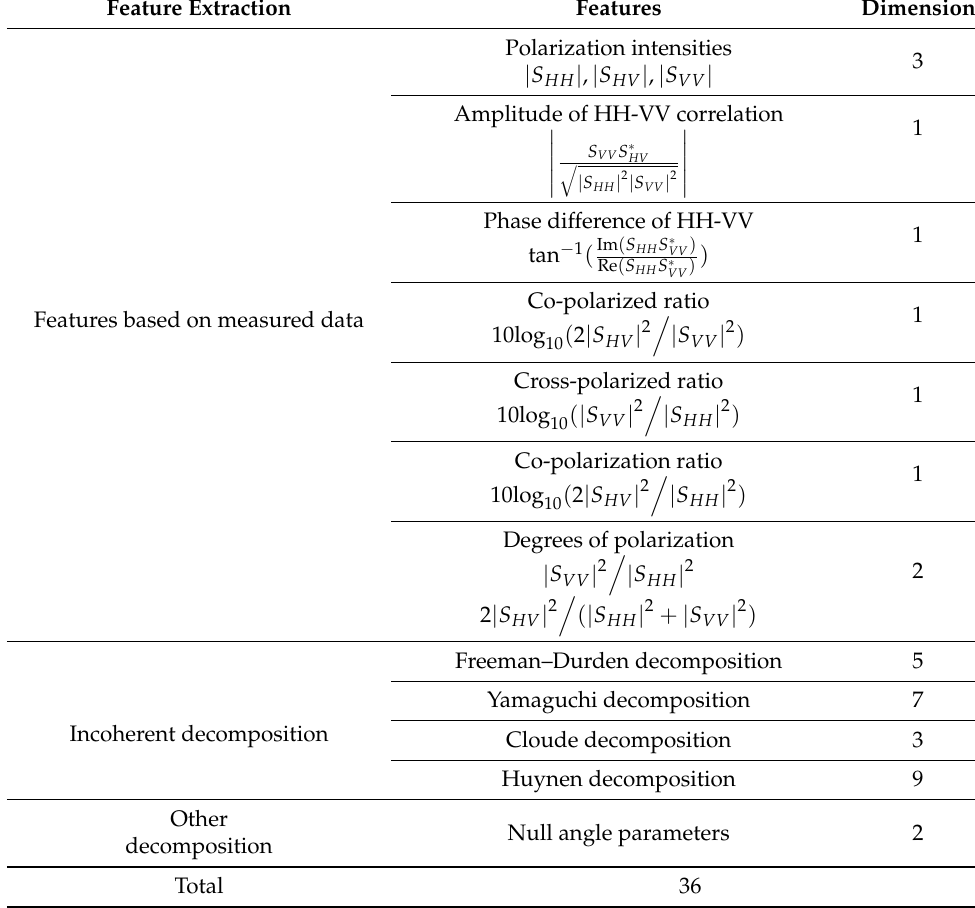
Table 1. The 36-dimensional features of quad PolSAR